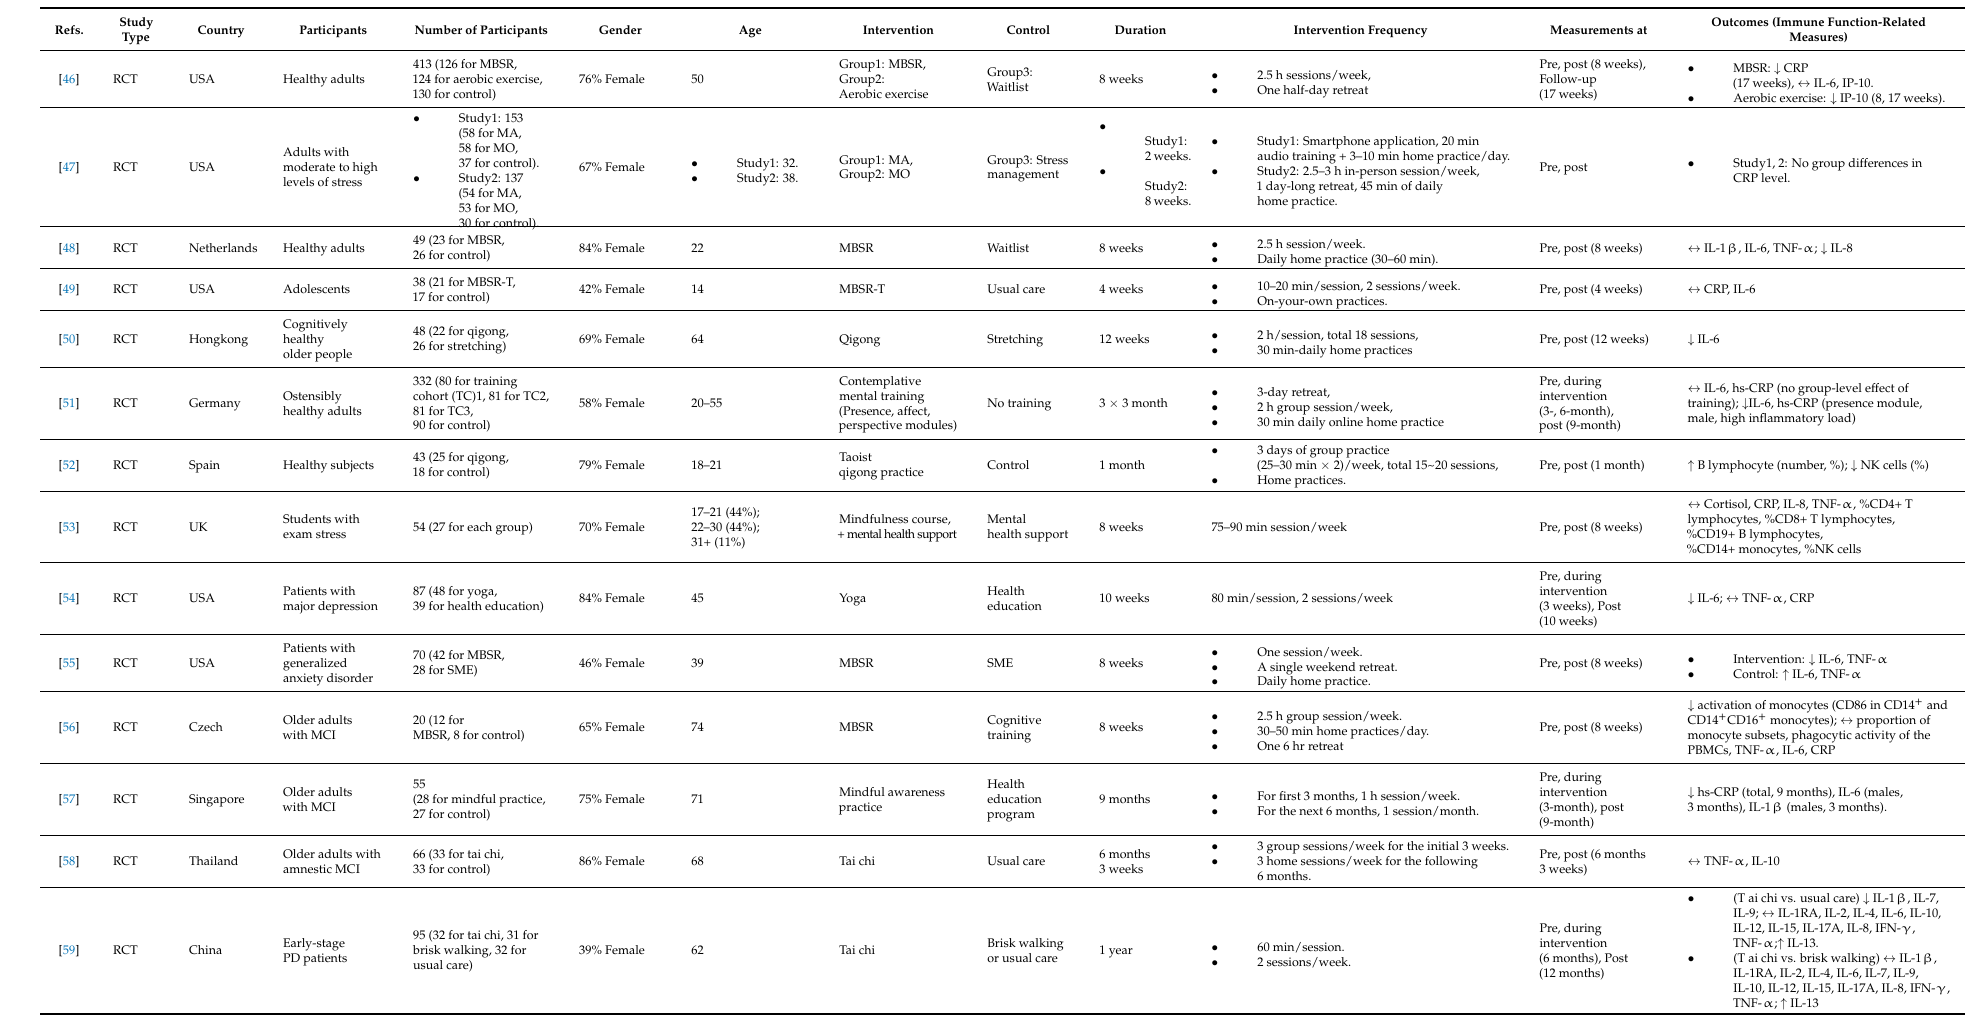
Table 2. Effects of the Mind–Body Intervention on immune function. Randomized controlled trials over the recent 5 years regarding the effects of the Mind–Body Intervention on immune function-related measures were summarized.